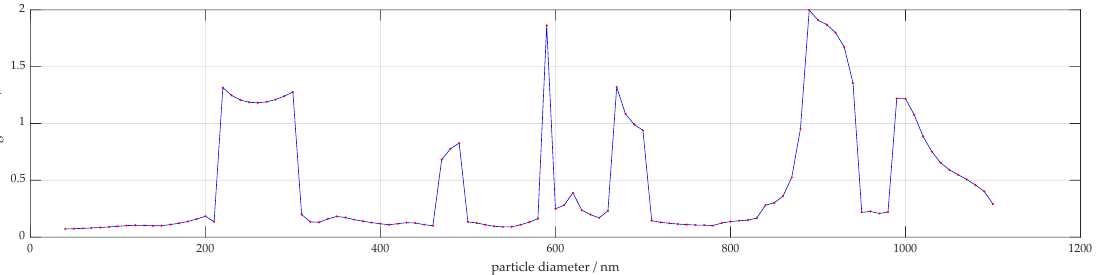
increments from 20 ◦ to 160 ◦ . ( a ) Measurement and sinusoidal fit; ( b ) comparison to best fit result with 95% confidence intervals shown in gray; ( c ) comparison to actual particle size.